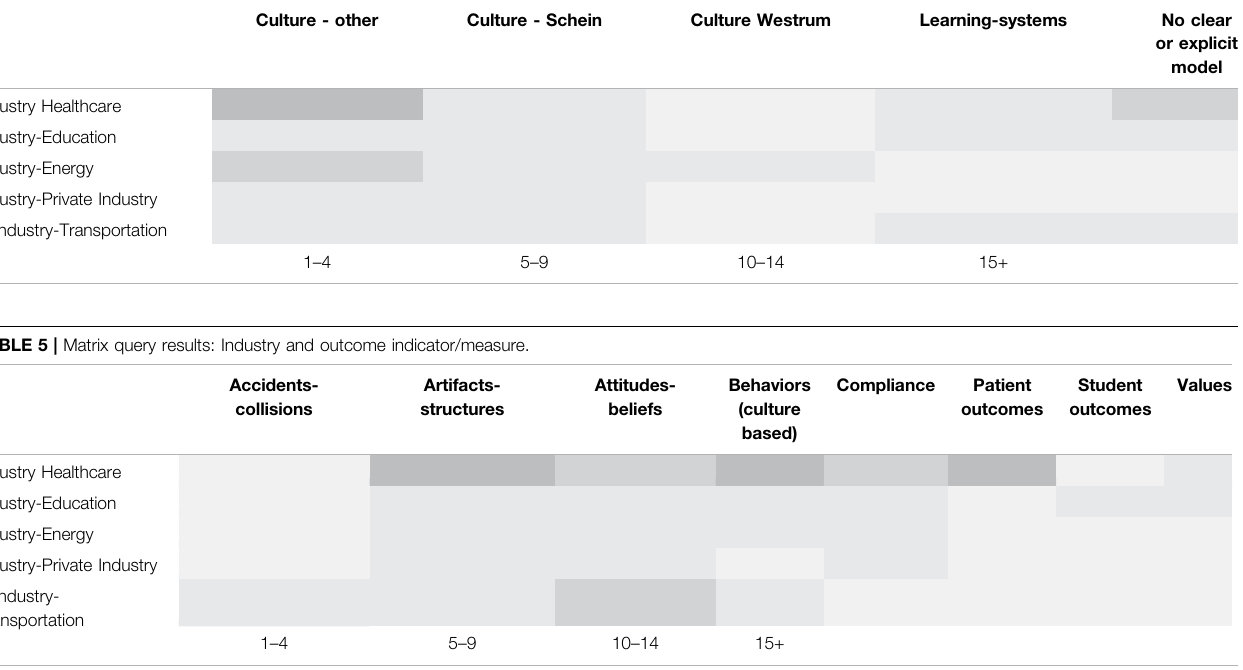
TABLE 4 | Matrix query results: Industry and culture model.